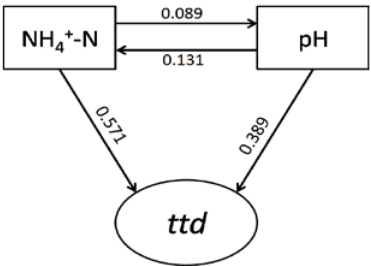
Figure 4. Path analysis of survival time ( ttd ) and water physicochemical properties (NH 4+ –N, pH).